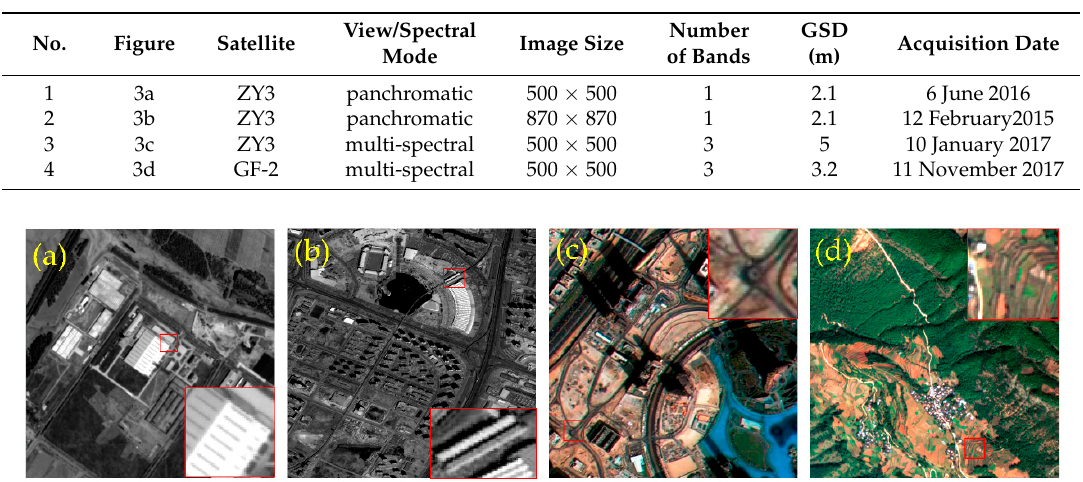
Table 1. Parameters of simulation experimental imagery.